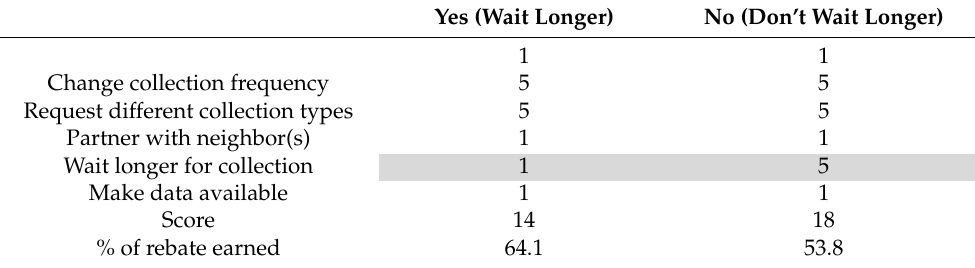
Table 6. Impact of waiting longer for waste collection.